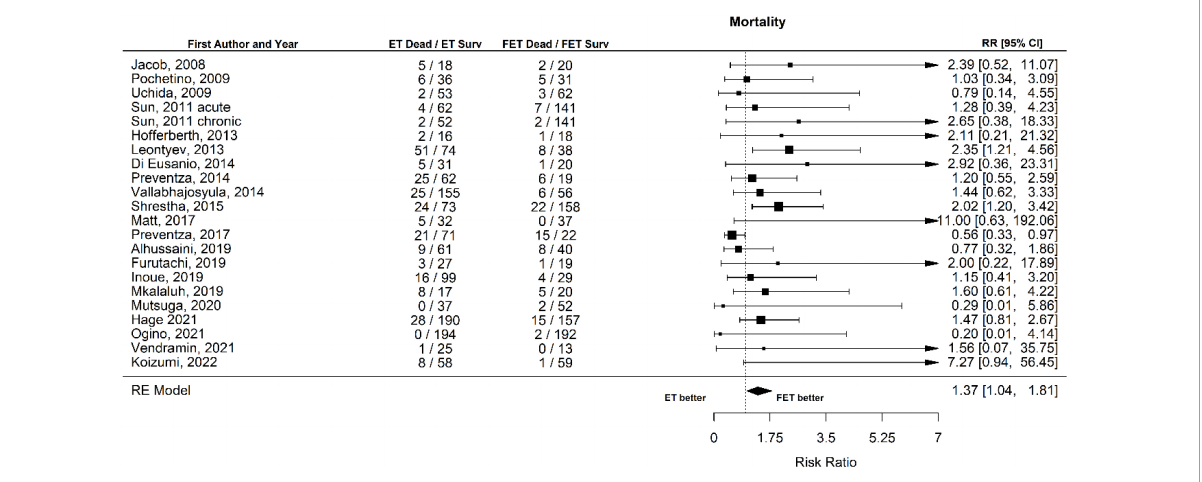
FIGURE2 Relative risk of mortality in patients undergoing aortic interventions with conventional elephant trunk (ET) vs. frozen elephant trunk (FET). Forest plot. ET vs. FET p =